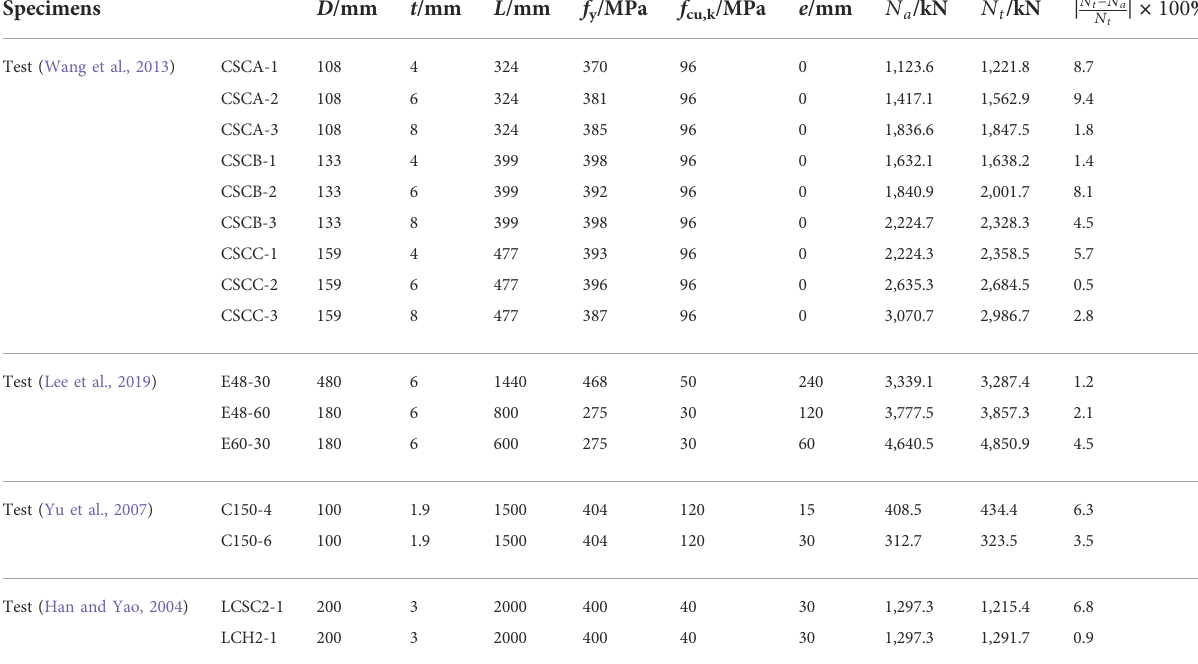
TABLE 2 Comparison between N a and N t